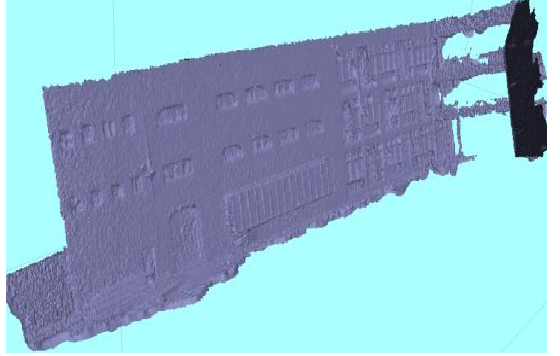
Figure 10: Shaded model generation